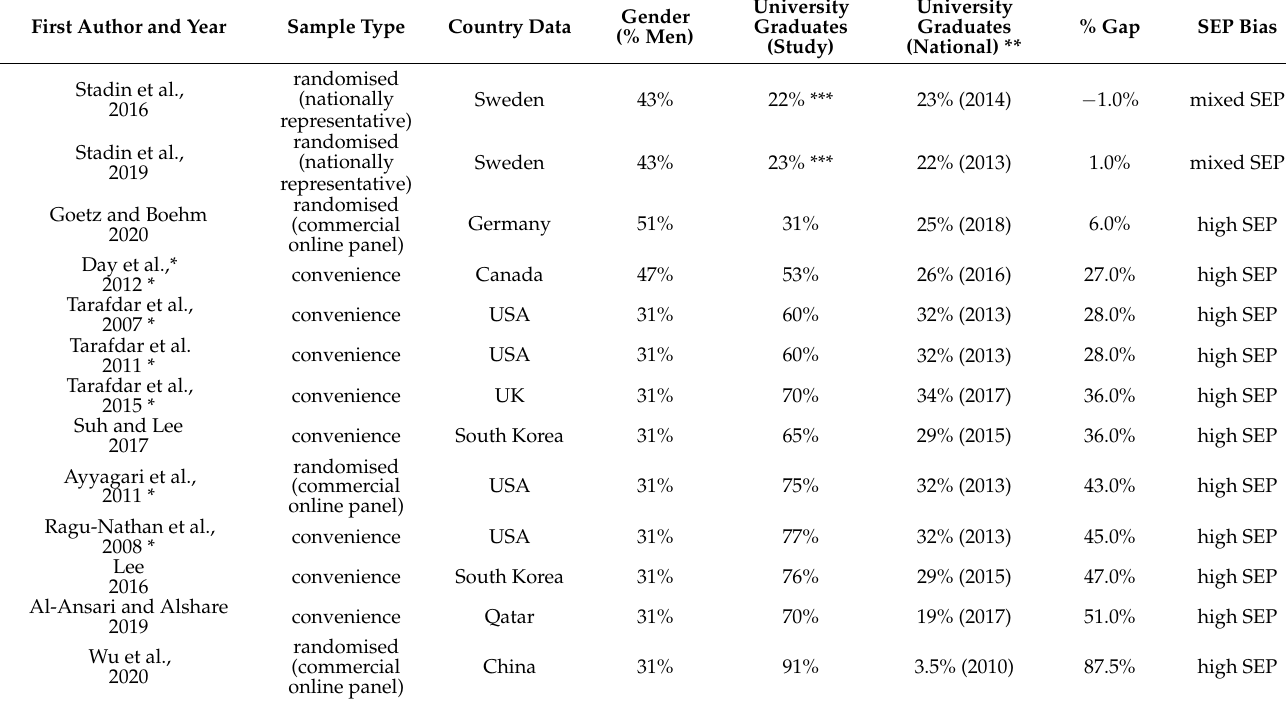
Table 4. Socioeconomic sampling bias in a subsample (sorted by % gap in university